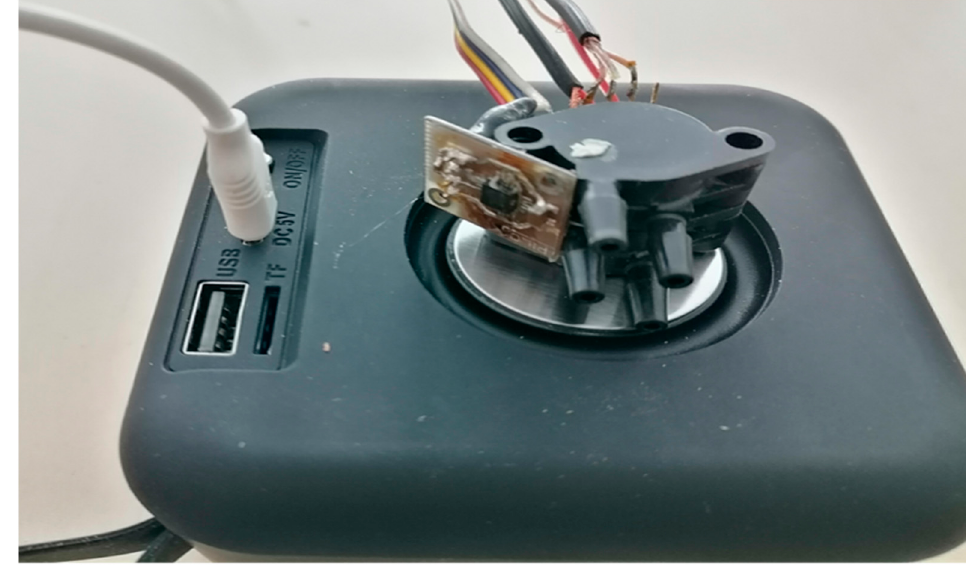
Figure 9. Photo of the installed hybrid sensor on the dynamic electrodynamic emitter.